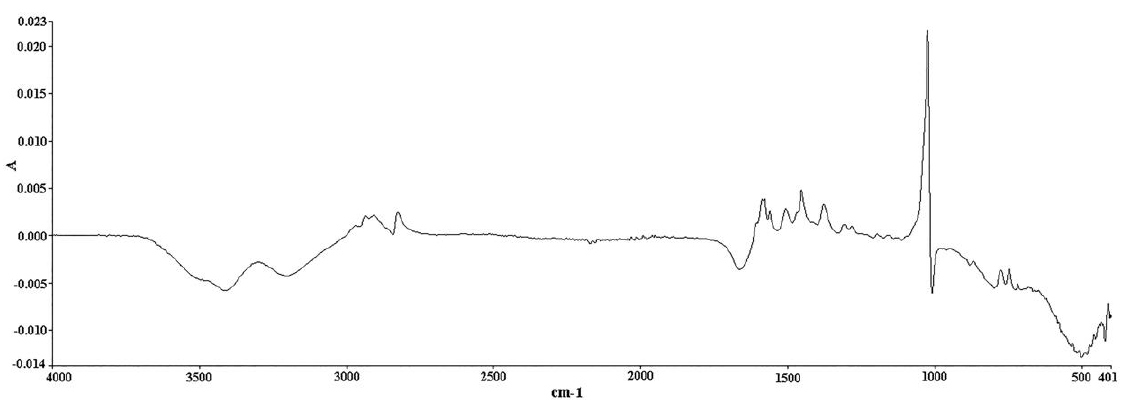
Figure 7. ATR FT-IR spectrum of DS (standard compound) in powder form (abscissa units: wavenumber (cm −1 ); ordinate units: absorbance).